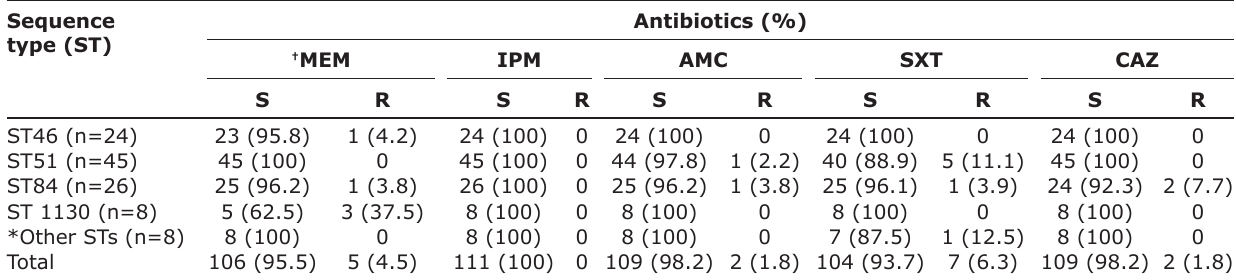
Table-2: Distribution of antibiotic resistance and susceptibility E-test MIC by ST of Burkholderia pseudomallei . Sequence type